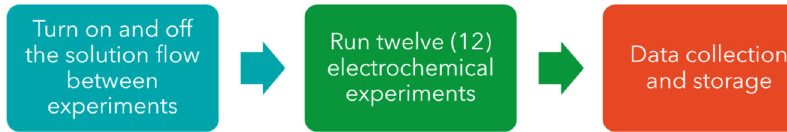
Fig. 1 Ammonia Electrooxidation Lab at the ISS electrochemical experimental cycles summary.